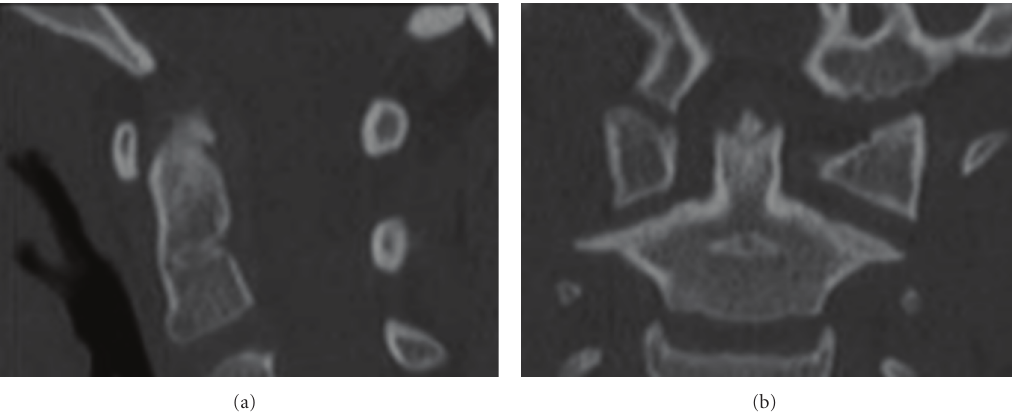
Figure 2: (a) Sagittal and (b) coronal reformatted CT scan confirming normal appearance of the odontoid